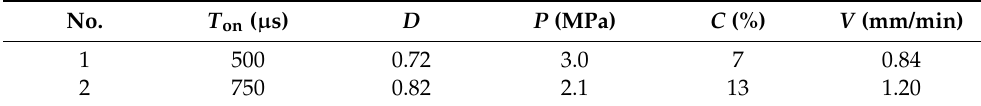
Table 3. Validation